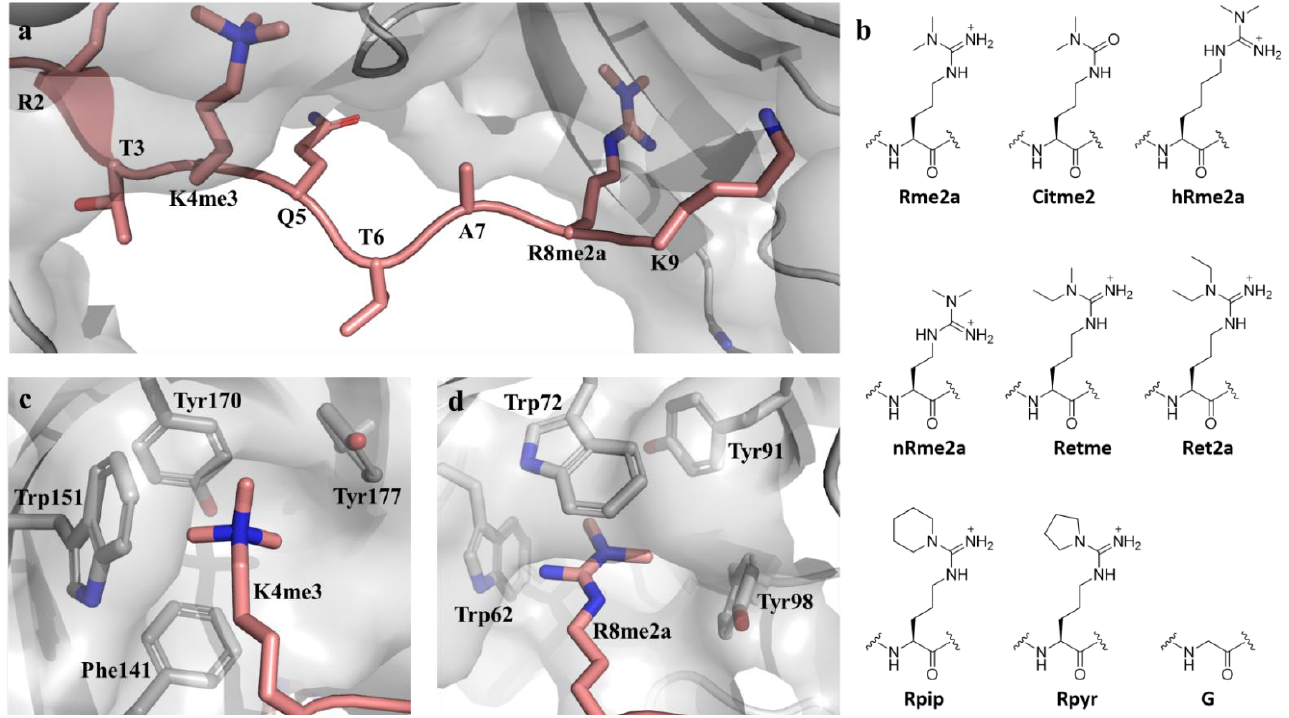
Figure 1. ( a ) Crystal structure of Spindlin1 containing the two neighbouring aromatic cages bound to H3K4me3R8me2a (PDB-ID: 4MZF); ( b ) Exploring the binding scope of Spindlin1 by